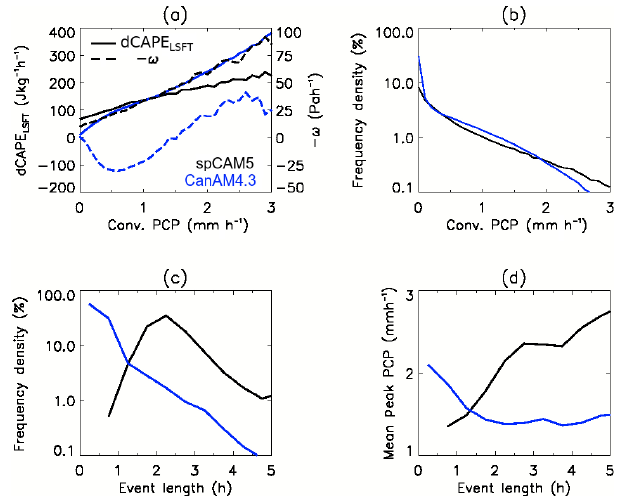
Figure 1. (a) Mean values of CAPE generation in the free tro- posphere (solid) and near-surface large-scale − ω (dashed) per 0.1mmh − 1 convective precipitation bin in spCAM5 (black) and CanAM4.3 (blue). (b) Frequency density of convective precipita- tion per 0.1mmh − 1 bin. Frequency density of 1 % in panel (b) , or 1mmh − 1 convective precipitation in panels (a) and (b) , corre- spond to 82 CanAM4.3 and 122 spCAM5 samples per grid cell. (c) Frequency density of convective event length, and (d) mean peak convective precipitation as function of convective event length. Fre- quency density of 10% in panel (c) corresponds to 33 CanAM4.3 and 83 spCAM5 convective events.